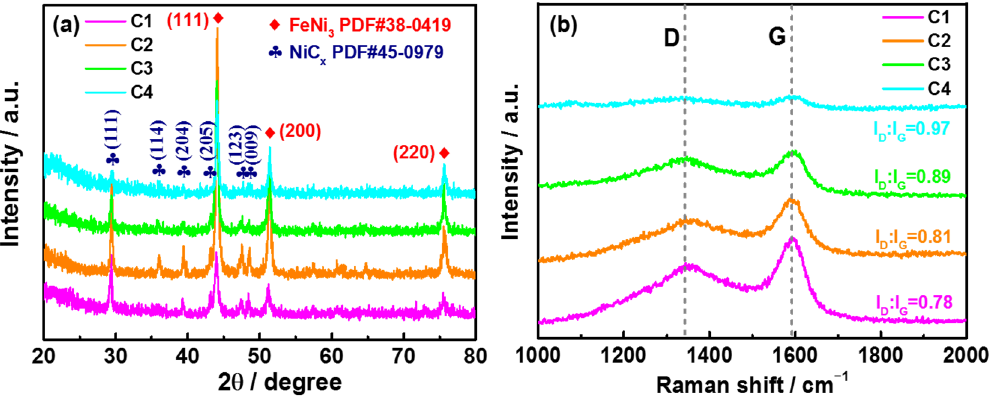
Figure 2. XRD curves ( a ) and Raman spectrum ( b ) of C1–C4 composites.